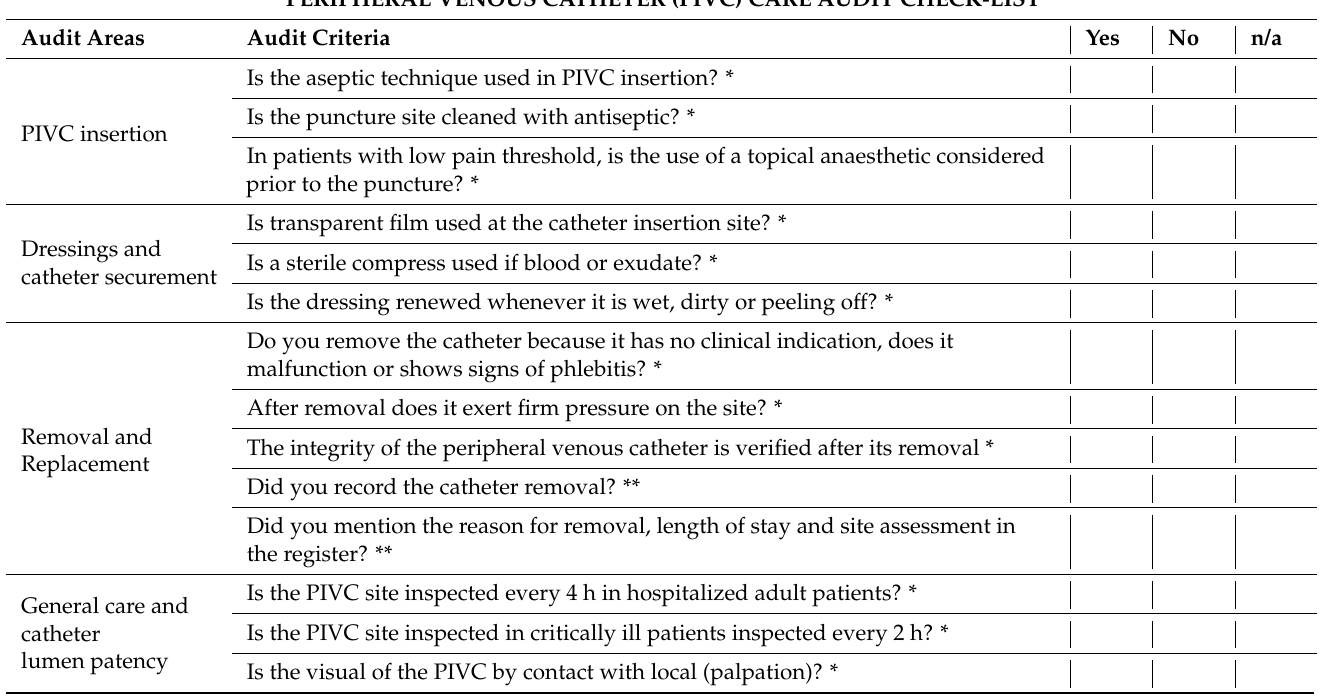
Table 2. Audit checklist with best practice